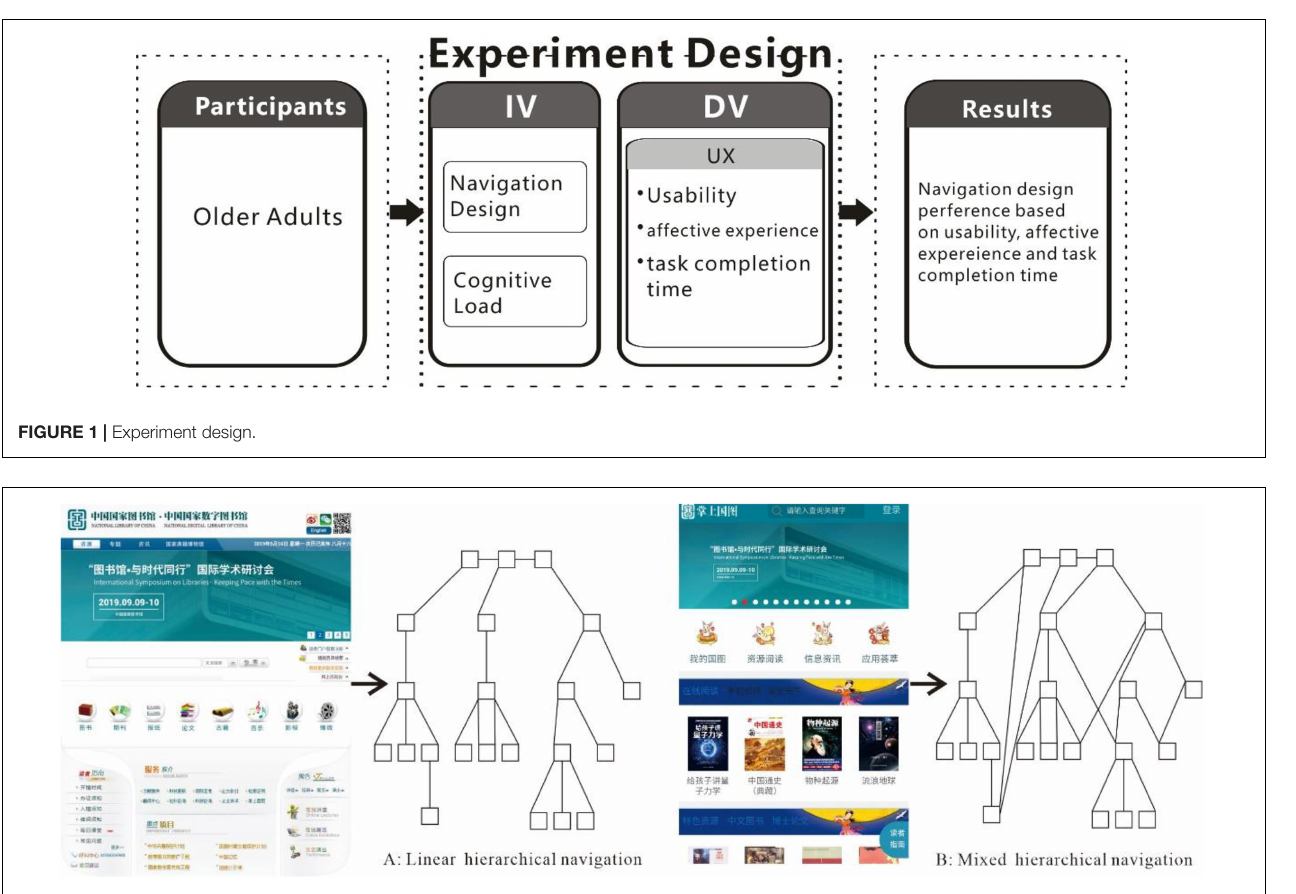
FIGURE 2 | Two versions of navigation structure of NDLC websites.